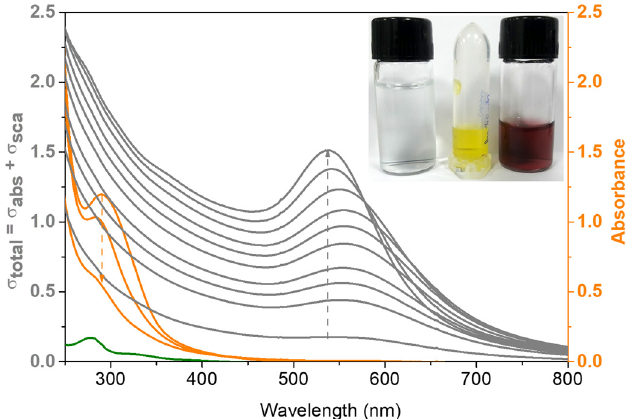
Figure 1. UV-Vis spectra acquired during the time-course of the NanoBro synthesis. Green line shows the HEPES-buffered Bro solution. Orange lines show the spectral changes of HAuCl 4 in subsequent times after addition to Bro solution as indicated by the arrow. Gray lines show the increase of absorbance and turbidity resulted from NanoBro formation. The inset shows a snapshot of the HEPES-buffered Bro transparent solution, the yellow HAuCl 4 aqueous solution and the red-wine GNP suspension. The synthesis was carried out at pH 7.0 at the temperature of 40 °C and the spectra were obtained in a quartz cuvette with 1 cm of optical path.